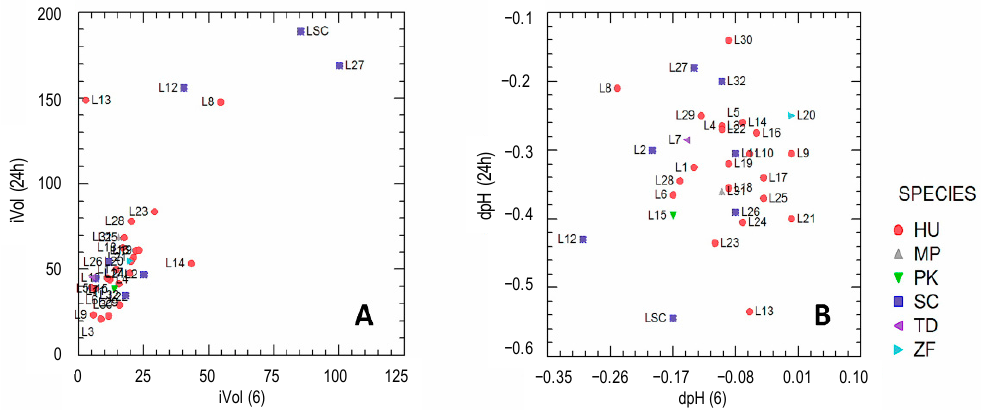
Figure 2. Leavening (volume increase of doughs, iVol; panel ( A )) and acidifying (pH decrease of doughs, dpH; panel ( B )) ability of yeast strains, after 24 h and 6 h of incubations. Symbols and colors indicate the membership to different species. HU, Hanseniaspora uvarum ; MP, Metschnikowia pulcherrima ; PK, Pichia kudriavzevii ; SC, Saccharomyces cerevisiae ; TD, Torulaspora delbrueckii ; ZF, Zygotorulaspora florentina.